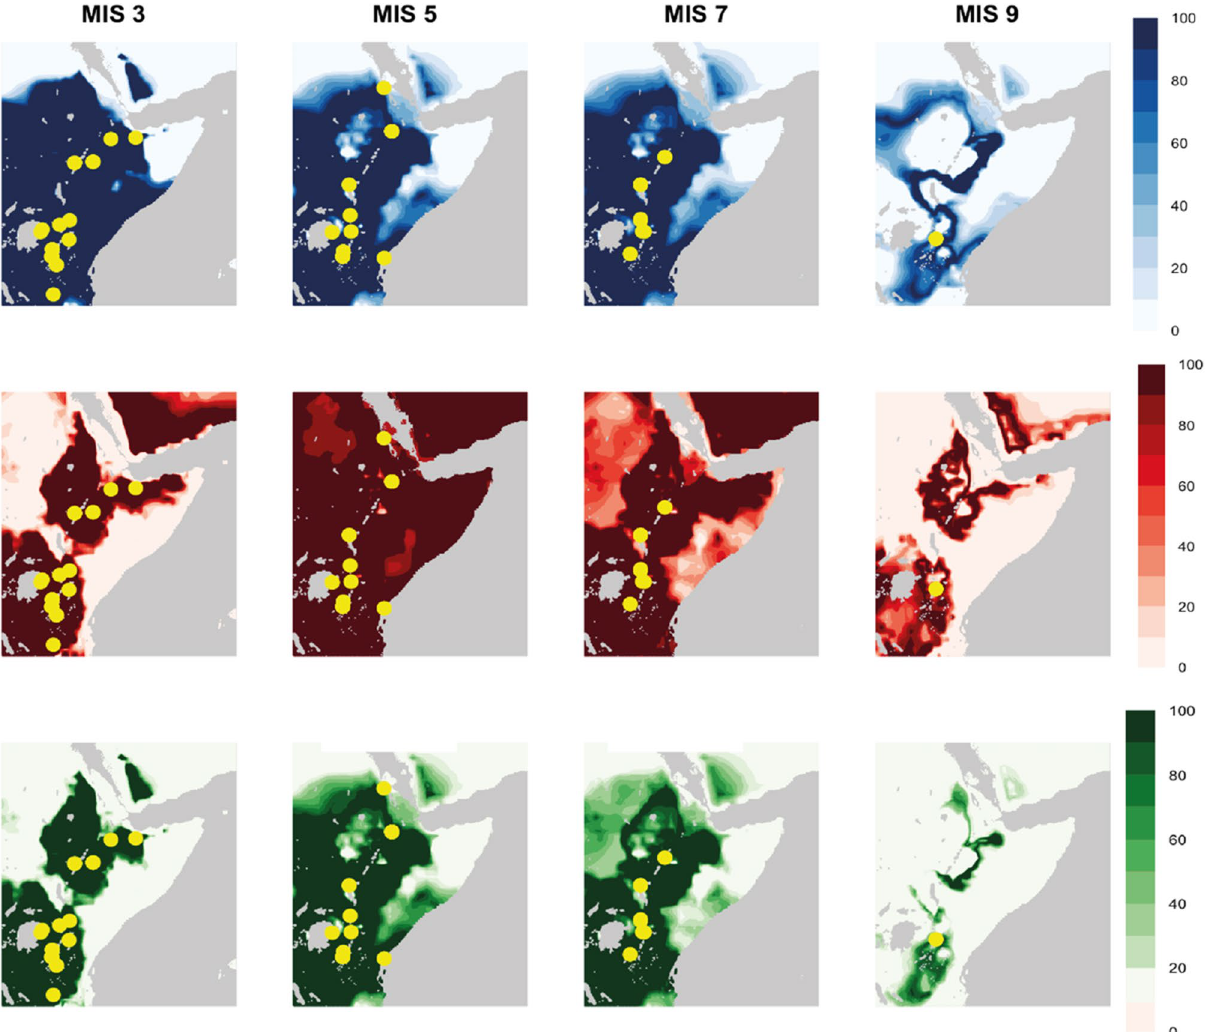
Figures 5. Mean annual temperature (top), total annual precipitation (middle) and combined (bottom) phased models of habitability, demonstrating the percentage of time intervals (1000 years per interval) that remain within the climatic range of the occupations dated to that Marine Isotope Stage (MIS). The palaeocoastline has been estimated based on the predicted mean sea-level for each